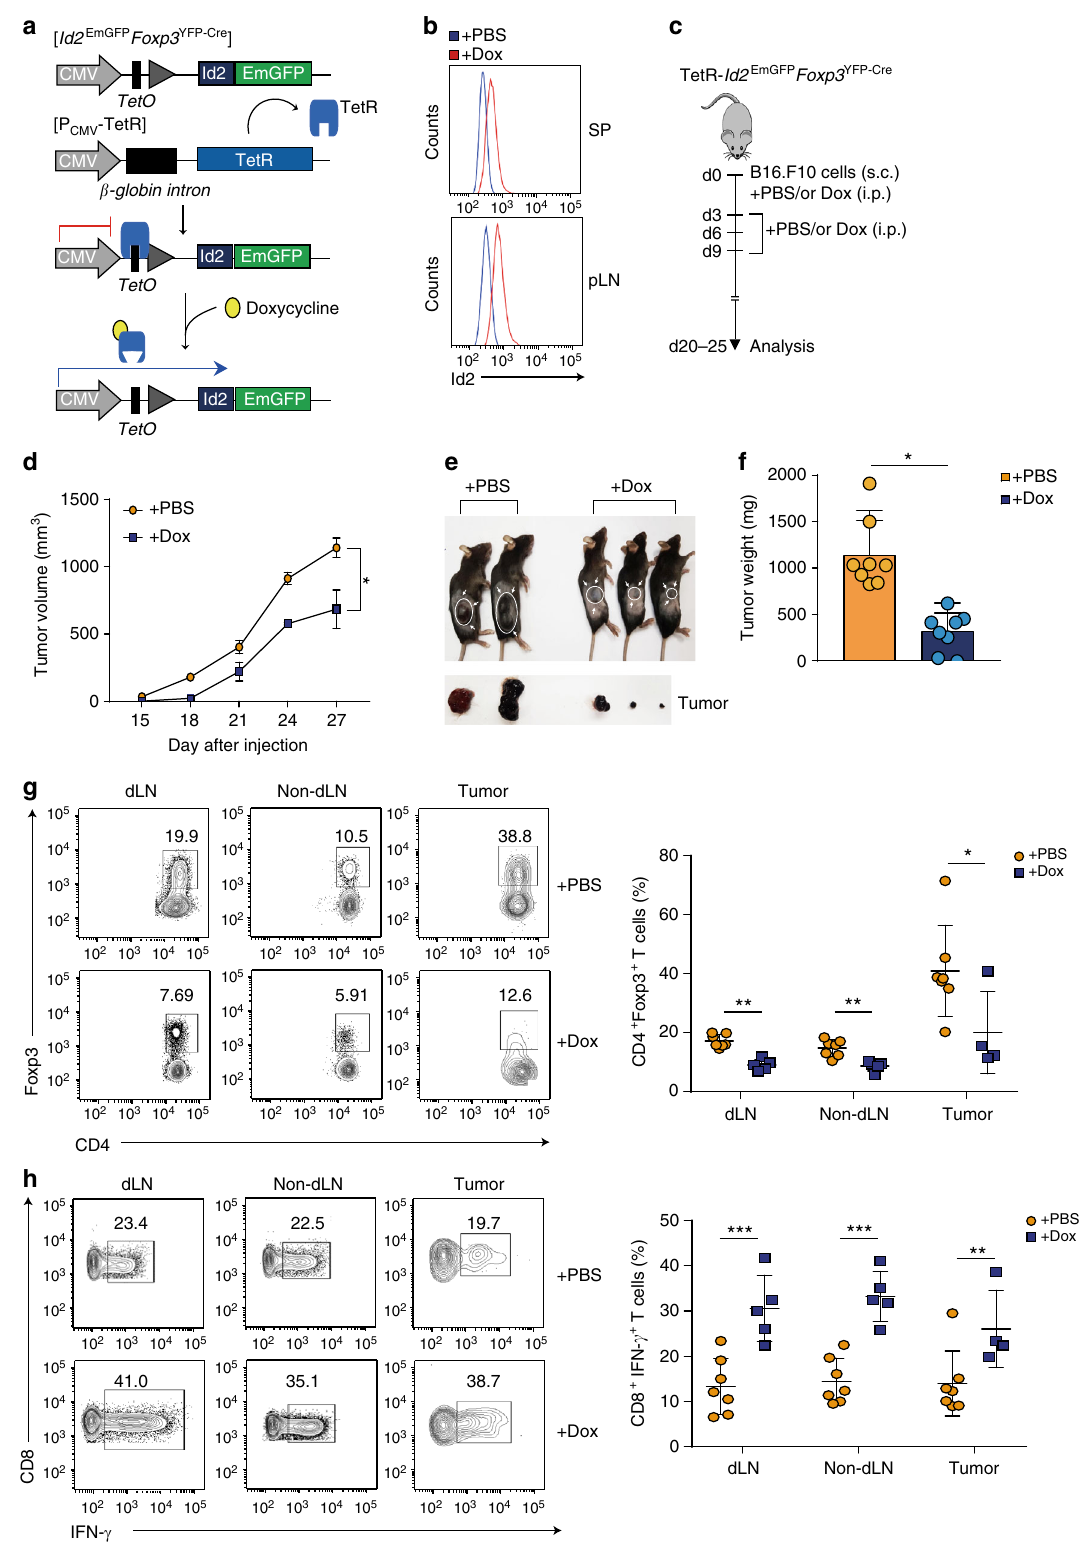
binding transcription factor E2A from binding to Foxp3 pro- protein binding sites in which E2A-mediated enhancement of moter. E2A, a well-known member of the E-protein family, has Foxp3 promoter activity could be signi fi cantly repressed upon been previously shown to promote transcription of Foxp3 by concomitant expression of Id2. Of note, while well characterized physically associating with multiple regions of Foxp3 promoter in conserved non-coding sequences (CNS1-3) within the Foxp3 T reg cells 32 . We found that Foxp3 promoter contains three E- locus have been implicated in various aspects of Foxp3 expression NATURE COMMUNICATIONS| (2018) 9:4736 |DOI: